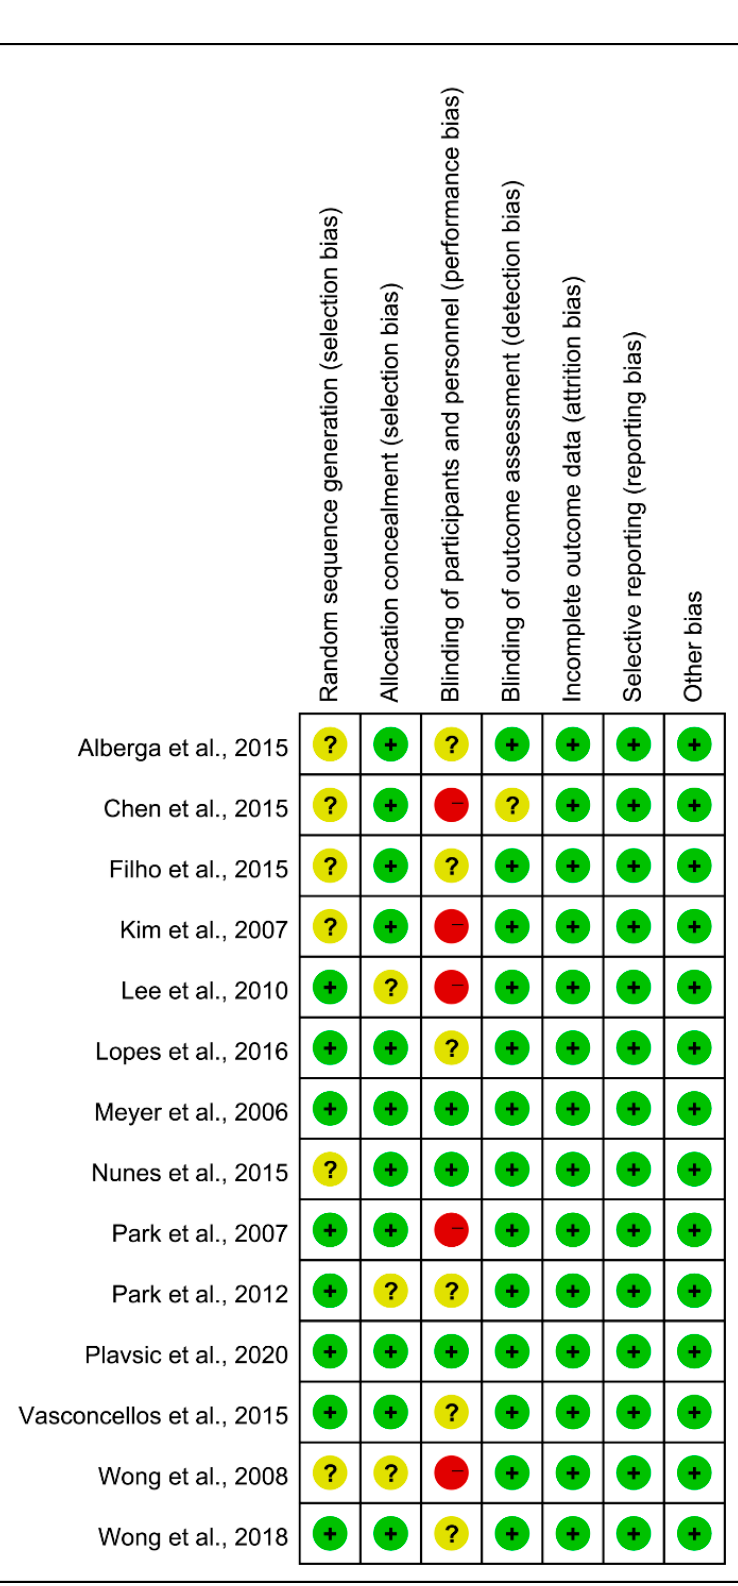
Figure 2. Risk of bias summary. Note: +—Low risk of bias; − —High risk of bias; ?—Unclear risk of bias.